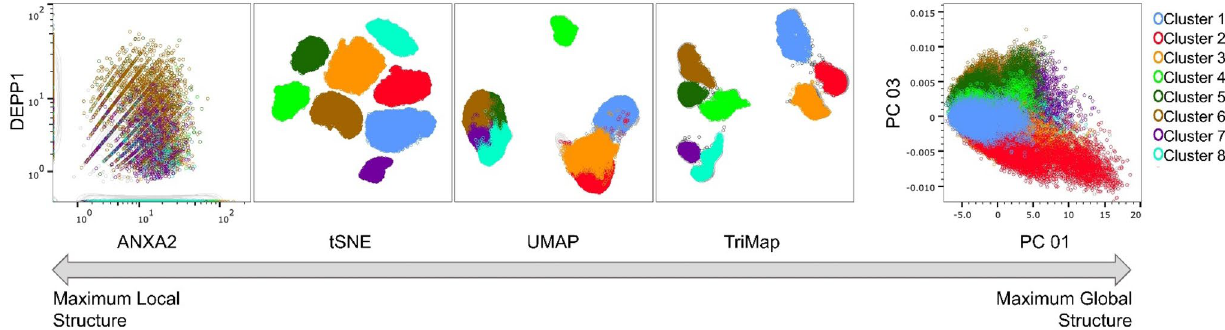
Figure 3. Dimensionality reduction using all genes in all cells. Dimensionality reduction summarizes the heterogeneous populations in a high dimensional space in a two-dimensional embedding. The DEPP1/ ANXA2 plot depict the expression of the two genes in the different clusters in a two-dimensional embedding. The tSNE, UMAP, TriMAP and PC plots depict the expression of all genes in higher dimensional space in a two-dimensional embedding. Thus, from left to right the data depicts maximum local structure (for example the needles on a pine tree) to maximum global structure (for example the clusters of pine trees in a pine forest). Eight clusters were identified by visual inspection of the TriMap